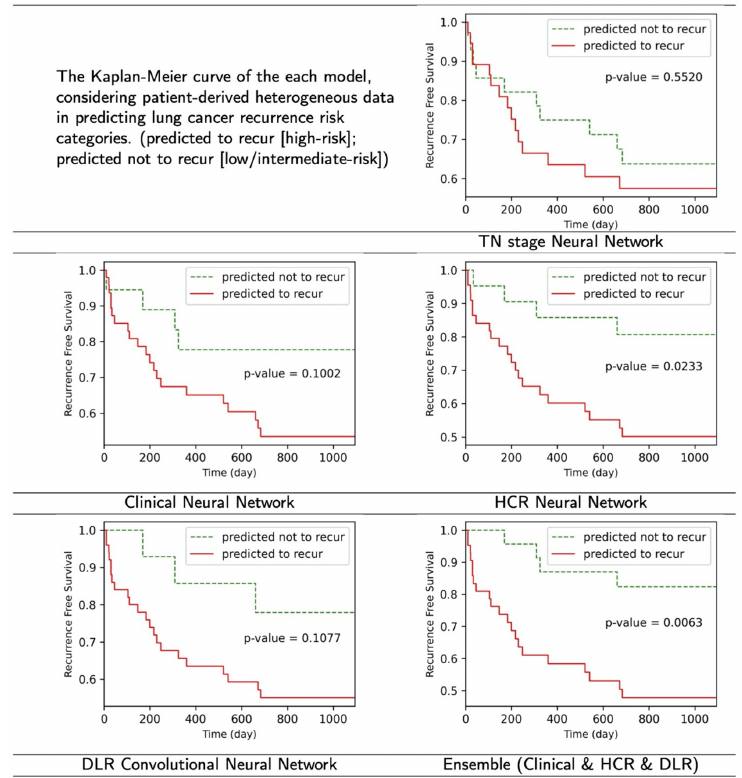
Figure 5. The result figures of Kaplan–Meier curve. The proposed ensembled model and HCR neural network model showed meaningful results ( p < 0.05), while others did not in the log-rank test.